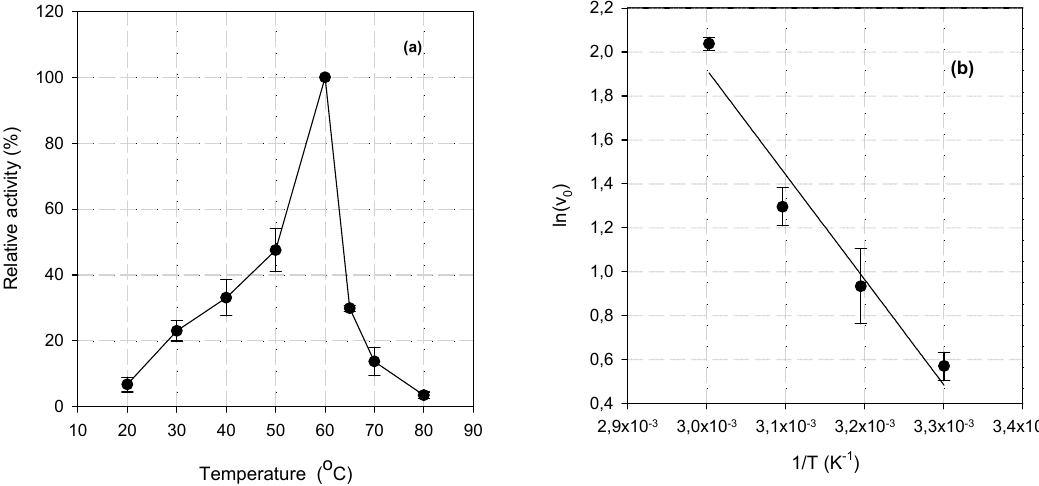
Figure 4. ( a ) The effect of temperature on BsXyn10 activity. ( b ) Arrhenius plot for the determination of the activation energy (E a ) of the reaction catalyzed by BsXyn10. The activation energy (E a ) of BsXyn10 for oat spelt xylan hydrolysis, calculated by the Arrhenius plot (Figure 4b) was found to be 39.8 kJ · mol − 1 . This value is comparable to that reported for the GH10 xylanases isolated from Arthrobacter sp. GN16 (29.74 kJ · mol − 1 ) [38] and B. halodurans TSEV1 (30.51 kJ · mol − 1 ) [11]. Higher activation energy (65.5 kJ · mol − 1 )